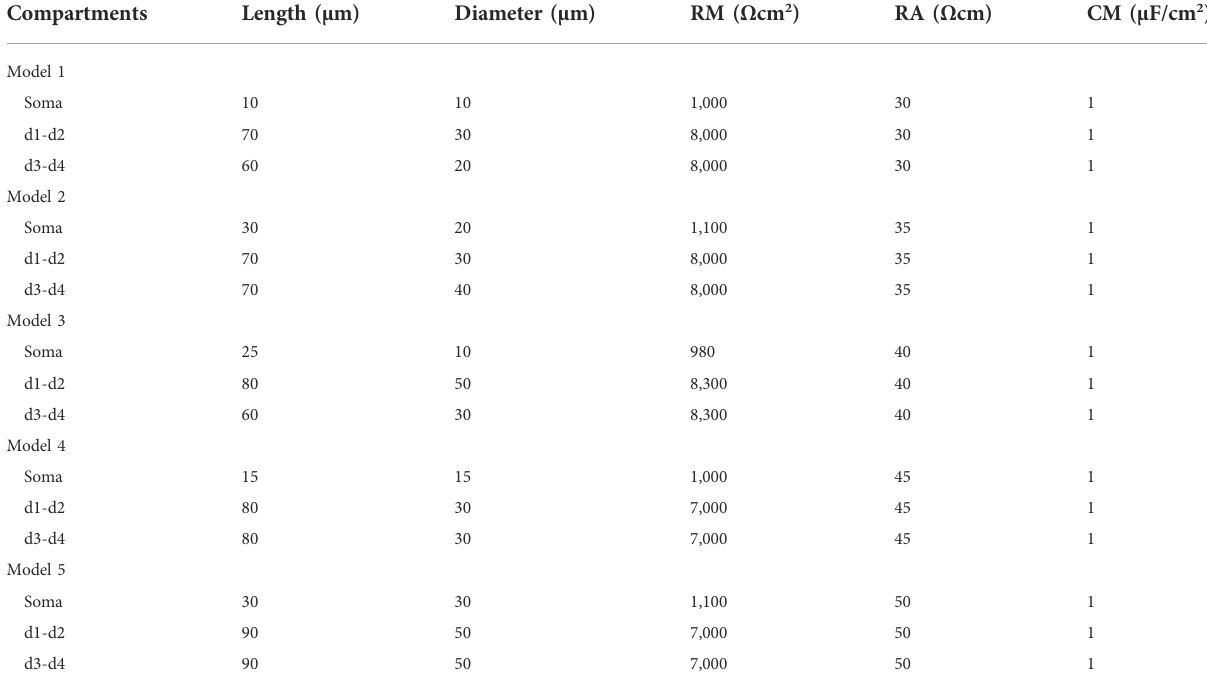
TABLE 2 Morphological parameters of hypoglossal